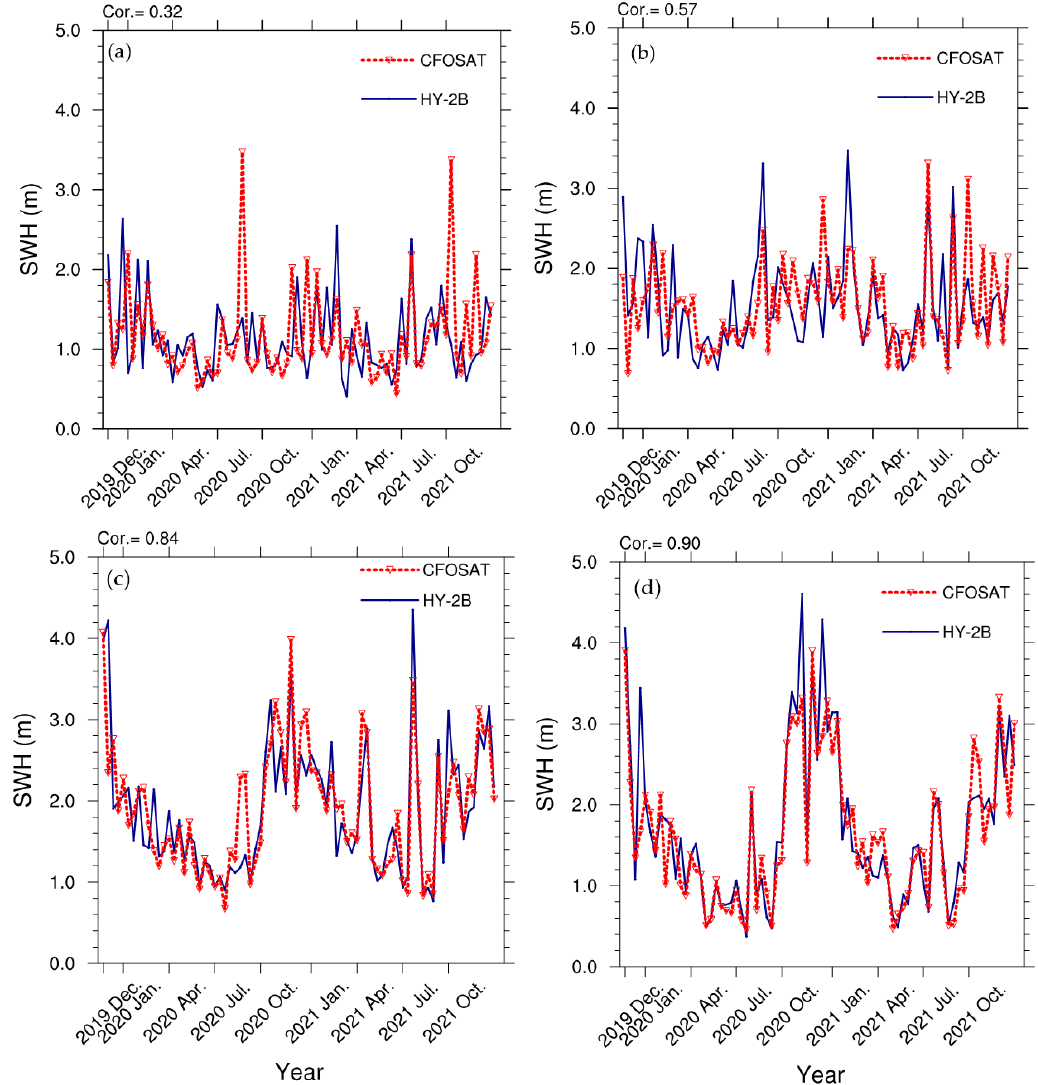
Figure 8. Field mean SWH variance from HY − 2B (blue line) and CFOSAT (red line) for every 10 − day mean series from December 2019 to December 2021 (78 time series in total). The selected waters are shown in Figure 7k,l (red boxes). The boxes, from north to south, are Huanghai ( a ), Donghai ( b ), east of Taiwan ( c ), and the central South China Sea ( d ), respectively. Among the four sea areas, it was interesting to find that the correlation coefficient increased with SWH magnitude. Compared with HY − 2B, more extreme high SWHs oc- curred in northern waters according to CFOSAT, such as in October in Huanghai (Figure 8a), leading to a smaller correlation coefficient. The CFOSAT SWHs varied uniformly with HY − 2B to the east of Taiwan (Figure 8c) and in the central South China Sea (Figure 8d). An intercomparison of CFOSAT and HY − 2B data over a larger domain with over 170,000 points was carried out between 60°S and 60°N (Figure 9a), with the criteria of a spatial window of 50 km and a time window of 30 min [34]. There were three peak zones of a total number of zonal points: one near the equator and the other two near the midlat- itude in the northern hemisphere and southern hemisphere. The SWHs from CFOSAT were consistent with those from HY − 2B in all SWH ranges, with a correlation coefficient of 0.99 (Figure 9b), which agrees with the findings of Li et al. [31]. It is worth noting that, in calm sea conditions (SWH < 1.25 m), CFOSAT and HY − 2B both tended to overestimate the SWH. Similar results were also found in the CFOSAT SWH validation against buoy observations in summer (relatively calm sea conditions) in Sections 3.1 and 3.2.